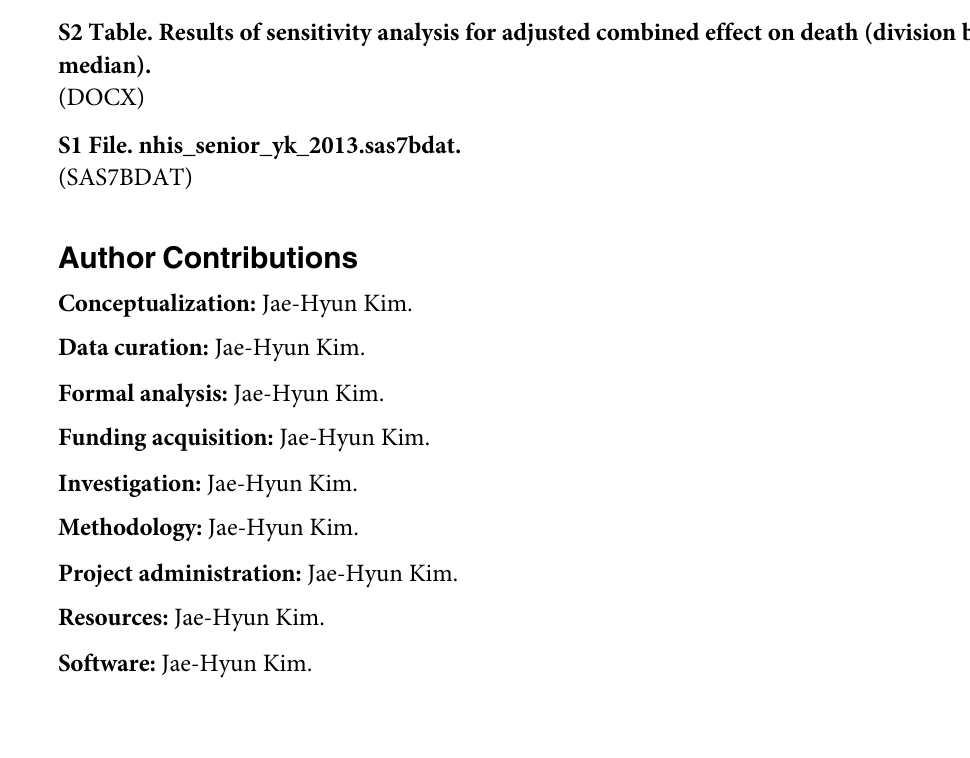
S1 Table. Results of sensitivity analysis for adjusted effect on death (division by median). S2 Table. Results of sensitivity analysis for adjusted combined effect on death (division by